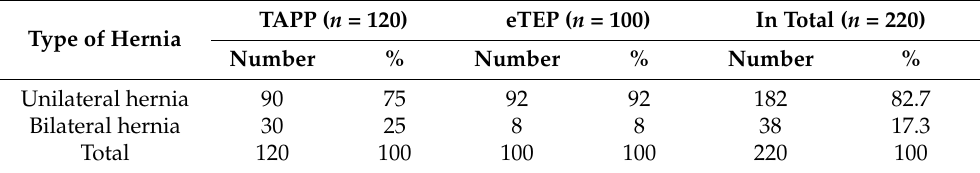
Table 2. Distribution by type of hernia.